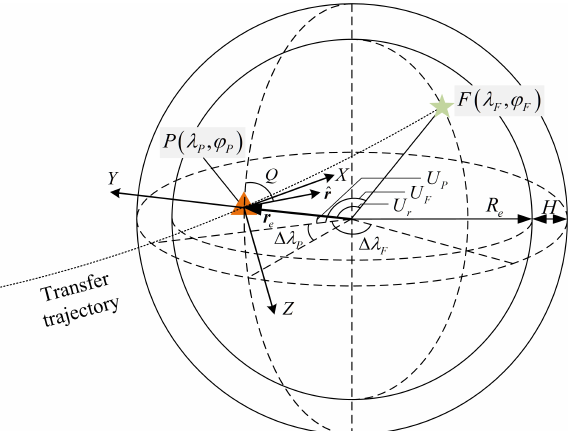
Figure 1. Re-entry coordinate frame OXYZ and parameters of re-entry